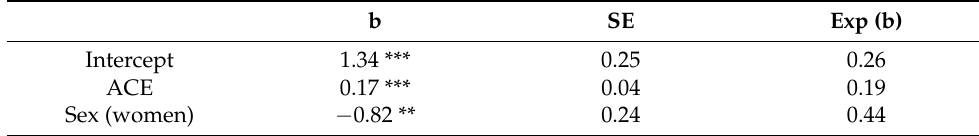
Table 8. Poisson Model for the alcohol and/or substance use problems.